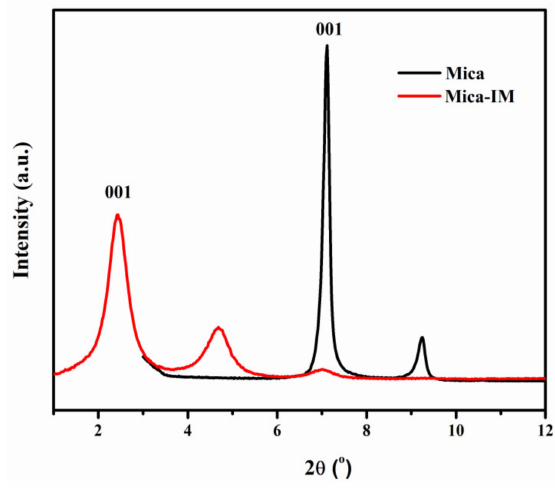
Figure 2. X-ray diffraction spectrum of the